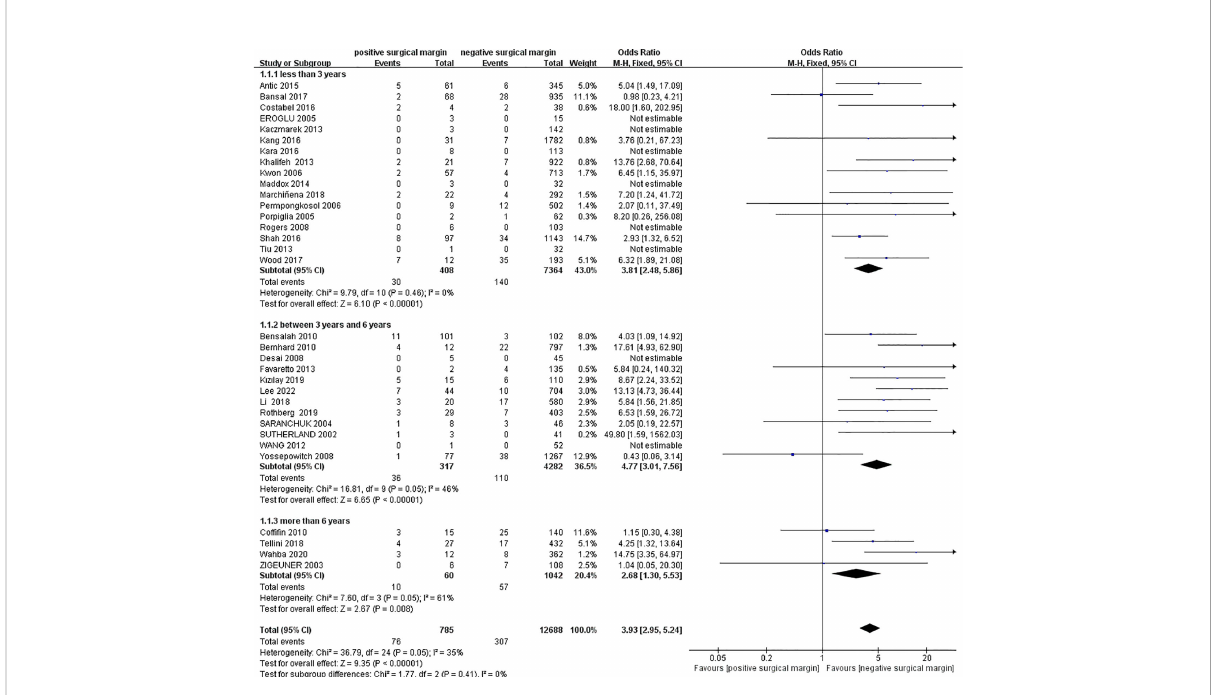
FIGURE 2 Comparison of local recurrence between positive surgical margin (PSM) and negative surgical margin (NSM)